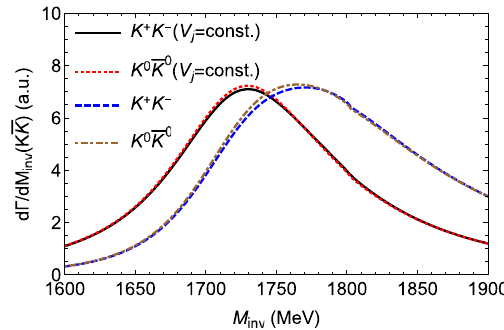
Fig. 9 Differential decays for the reactions J /ψ → φ K + K − , K 0 ¯ K 0 obtained with and without considering the triangle loop contributions. We have used the parametrization (iv) A = 0 ,α = − 1 ,β = − 0 . 32. In the case without the triangle contribution, we have replaced V by a factor ( − 2 . 0 × 10 − 2 ) to have a similar magnitude to the situation with the triangle loop